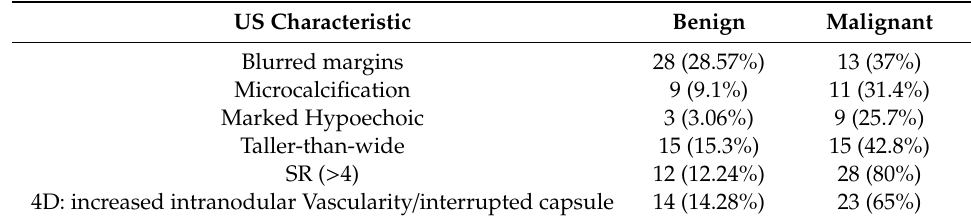
Table 4. Prevalence of suspicious features in benign and malignant groups.